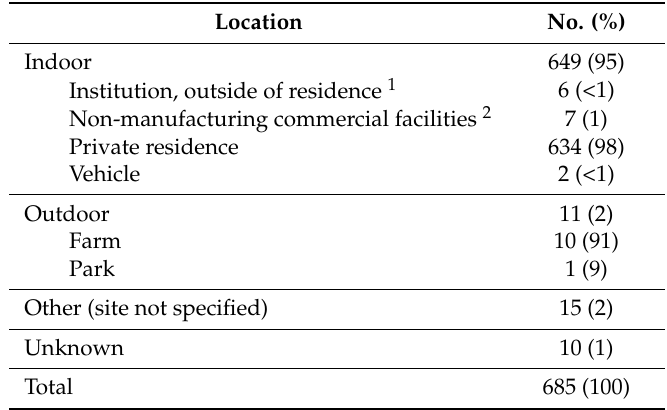
Table 9. Distribution of events in childhood reported by location where event took